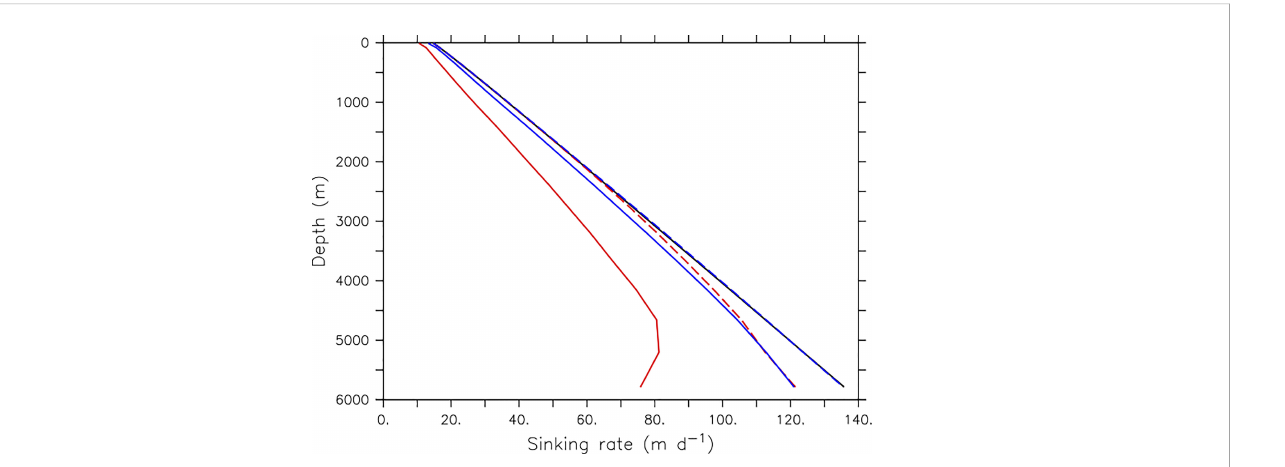
FIGURE 2 Calculated faecal pellet sinking rates. Black line is the default model parametrisation (Equation 3), which increases linearly with depth. Blue and red lines include rate modi fi cation following Equation 2, based on microplastic contamination and faecal pellet concentrations taken from Kvale et al. (2021) high- surface microplastic concentration output. Dashed lines use microplastic and faecal pellet concentrations from the year 2000, solid lines use model output from the year 2100. Blue colour indicates the assumption of all microplastic having the mass of small-size polystyrene beads, red colour indicates the assumption of all microplastic having the mass of large-size polystyrene beads (Cole et al.,